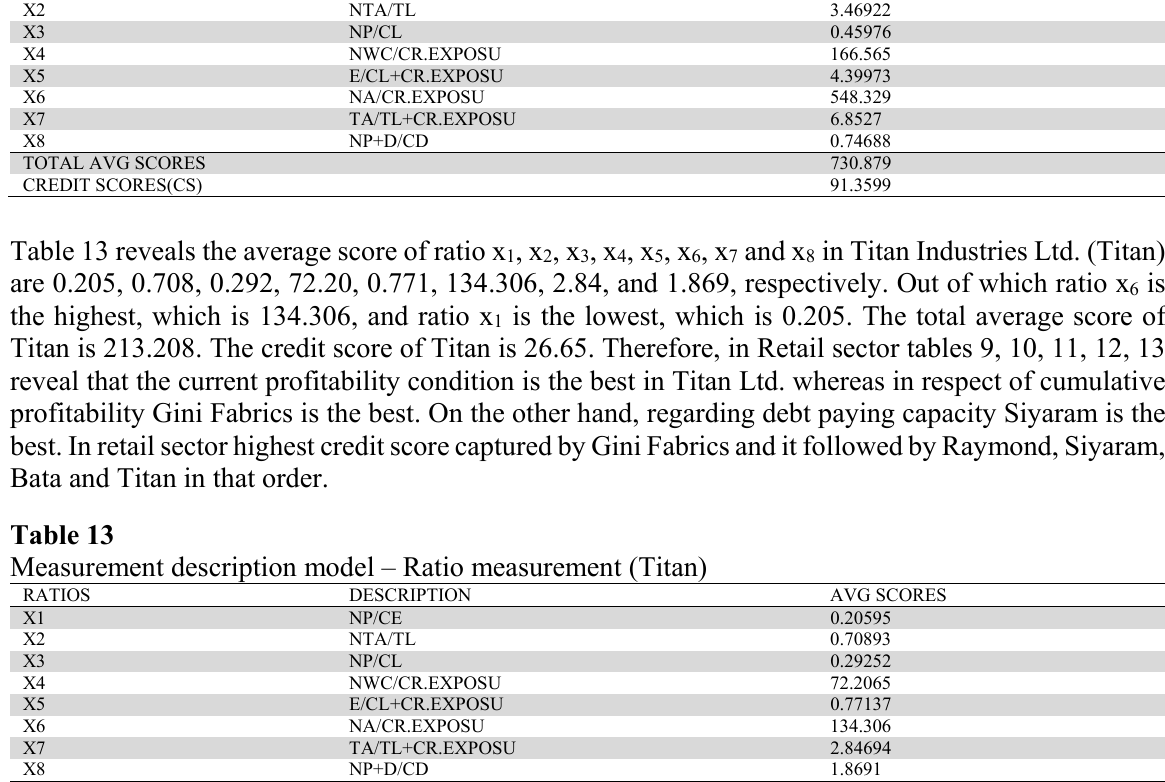
Risk description model – Ratio measurement (Raymond) RATIOS DESCRIPTION